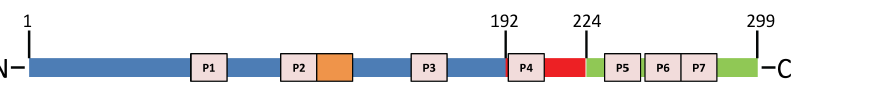
Figure 1. Schematic representation of apoE. The N-terminal domain (22 kDa), hinge, and C-terminal domain (10 kDa) are shown in blue , red , and green , respectively. Signature peptides used to quantify apoE based on the N-terminal domain (P1, P2, and P3), hinge (P4), or C-terminal domain (P5, P6, and P7) are shown as pink boxes. A unique peptide used to selectively quantify the apoE4 isoform is located in the N-terminal domain and shown as an orange box.